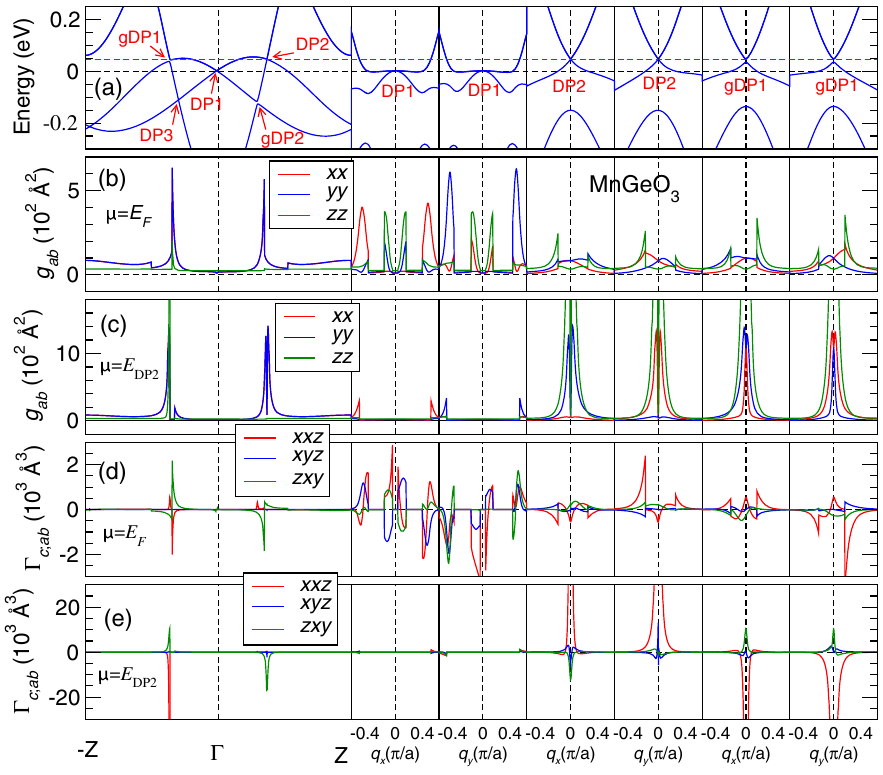
FIG. 5. Enhancement of geometric quantities near Dirac points. (a) Energy bands along the k also along the k and k directions through the DP1 and DP2 Dirac points as well as the gDP1 gapped Dirac point. (b,c) Quantum metric x y ( g ) along the same symmetry lines as in panel (a), calculated for the Fermi energy ( E ab Same as in panels (b) and (c), respectively, but for the Christoffel symbol of the first kind ( Γ momentum displacement from a DP (qDP)